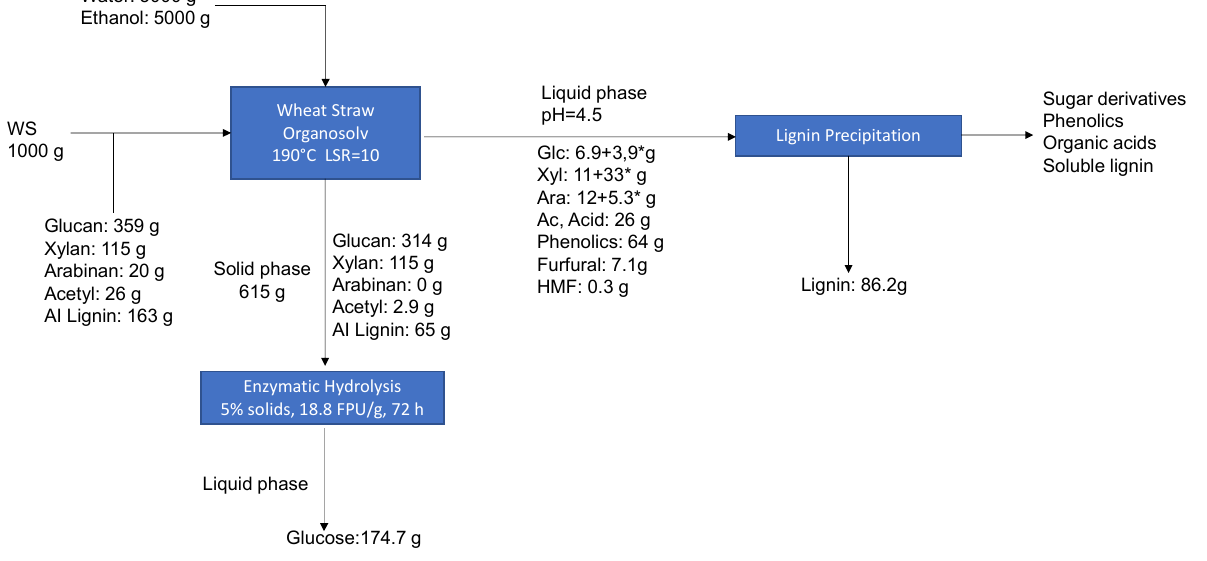
Figure 12. Mass balance of the main constituents for the ethanol organosolv processing of wheat straw at 190 °C (120 min) without catalyst, followed by enzymatic hydrolysis and lignin precipitation of the organosolv liquid stream. AI Lignin, acid-insoluble lignin; * Denotes sugars in oligomeric form.